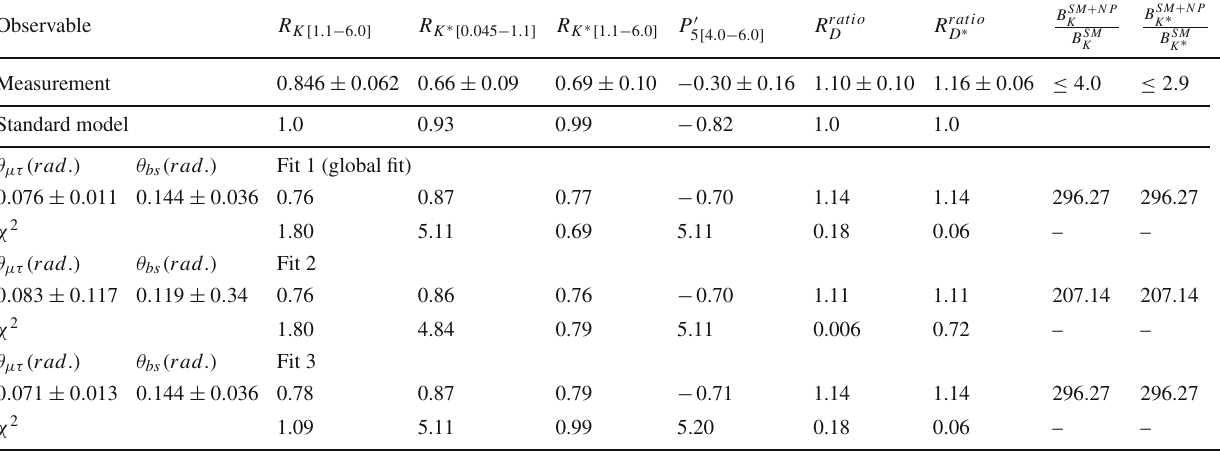
Table 4 Best fit values of the mixing angles in U 3 leptoquark model, For Fit 1, dof=122, χ 2 / dof = 0 . 97 Observable